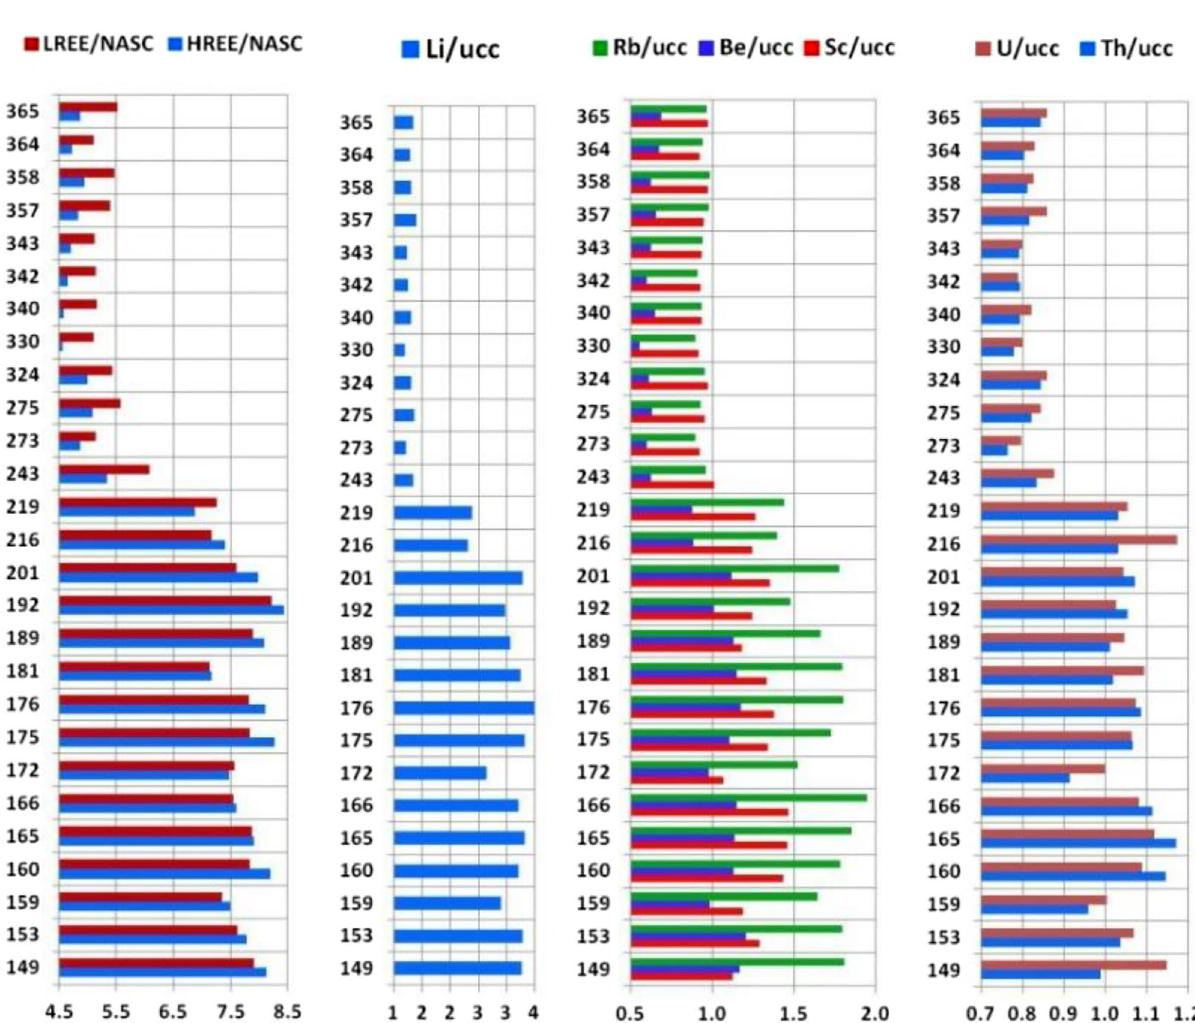
Figure 8. Distribution of lithophile element contents in Nalli Glacier cryoconite samples from altitudes of 149–365 m a.s.l. LREE = ∑(La, Ce, Pr, Nd, Sm, Eu, Gd); HREE = ∑(Tb, Dy, Ho, Er, Tm, Yb, Lu). The vertical axis shows the absolute altitude of the sampling spot, and the horizontal axis shows the normalized contents of the elements. Normalization standards: NASC—North American Shale Composite 50 , UCC—Upper Continental Crust 48